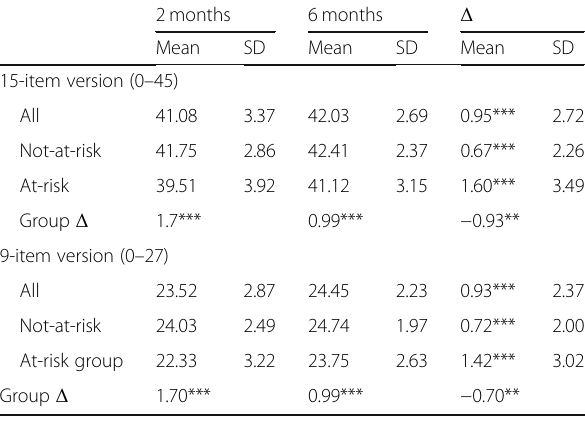
Table 5 KPCS means, standard deviations, and differences between and within groups for nine- and 15-item versions at two and six